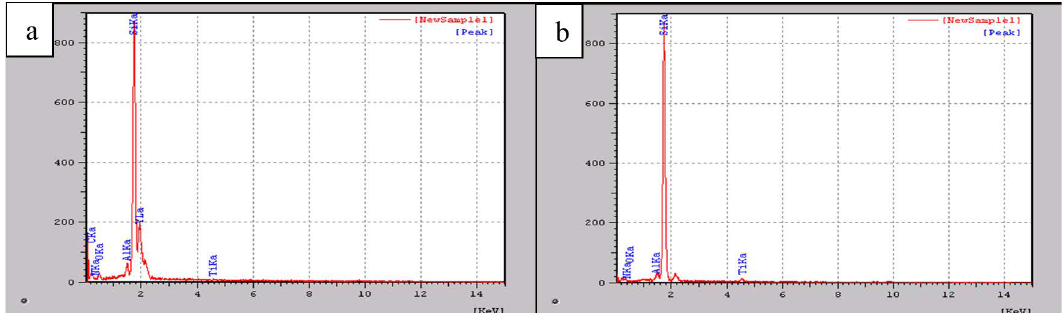
Figure 5. Energy spectrum analysis ( a ) Point A in Figure 4c; ( b ) Point B in Figure 4c.